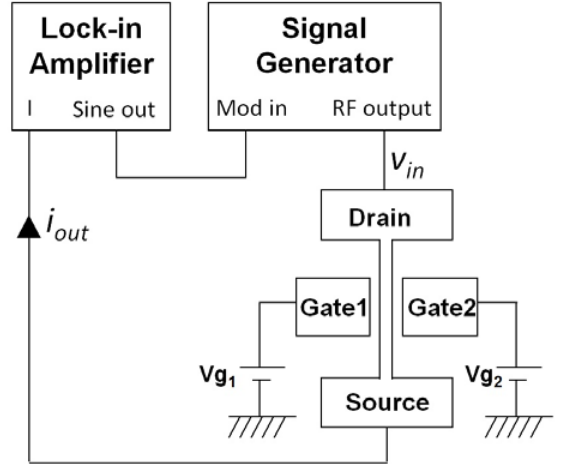
14. Down-mixing measurement setup for the in-plane resonant